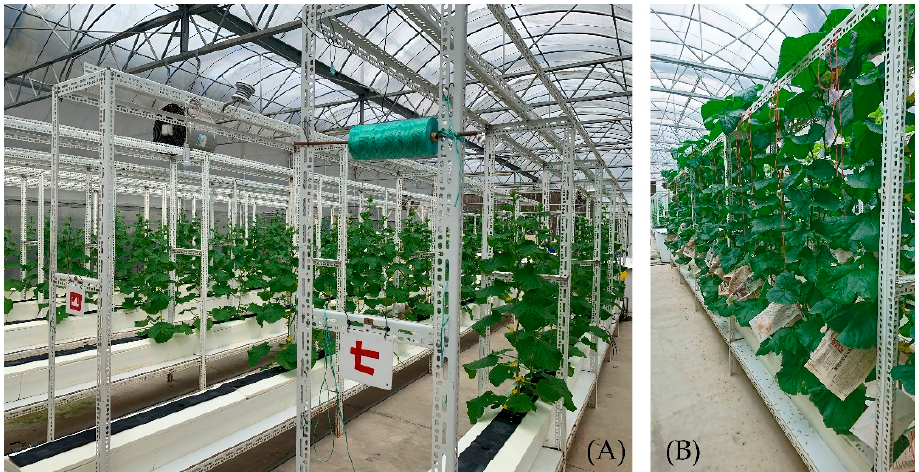
Figure 1. Hydroponic netted melon cultivated in the greenhouse in the present study. ( A ) Arrangement of the experimental set-up in the greenhouse; and ( B ) a hydroponic system.